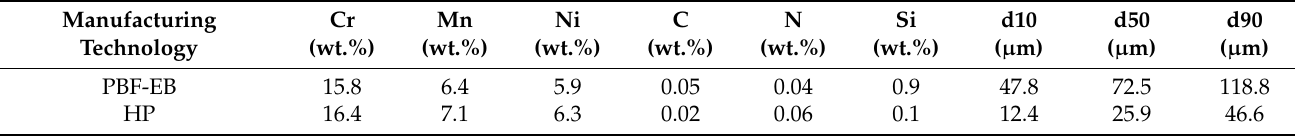
Table 1. Chemical composition and d 10 , d 50 , and d 90 values of the steel powders. The concentration of C was determined by the combustion infrared detection technique, N by inert gas fusion infrared and thermal conductivity detection, Cr and Ni by X-ray fluorescence spectroscopy, and the other elements by inductively coupled plasma spectroscopy.